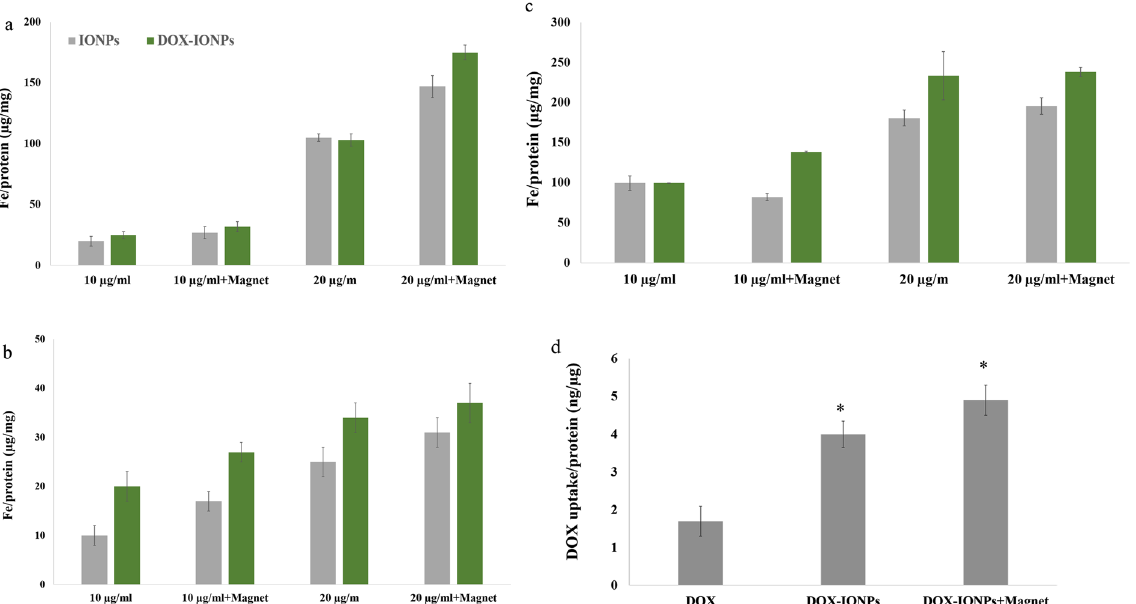
Figure 3. Uptake of EDT-IONPs and DOX-EDT-IONPs by ( a ) b.End 3, ( b ) MDCK-MDR1, and ( c ) U251 after 4-h treatment. ( d ) Uptake of DOX by U251 cells treated with either DOX, DOX-EDT-IONPs, or DOX-EDT- IONPs + Magnet after 2 h. *Indicates a significant difference compared to DOX at p < 0.05. Data is presented as mean ± S.D, and n = 3 (three replications). IONPs and DOX-IONPs represent for EDT-IONPs and DOX-EDT- IONPs.